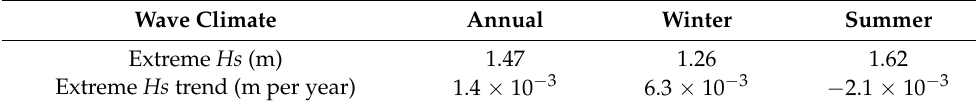
Table 2. Average extreme Hs and its trends for the period 1979 – 2005.